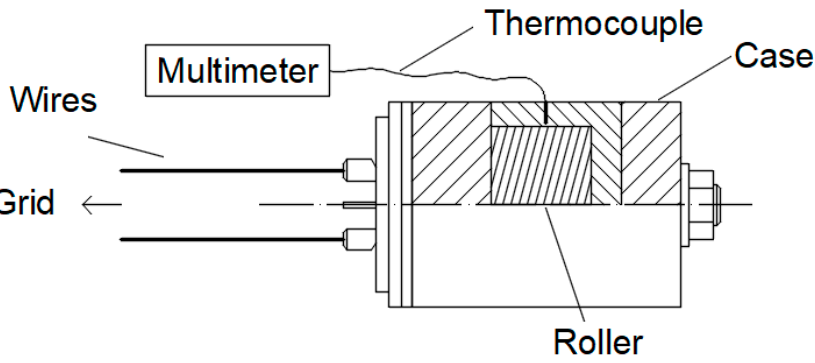
Figure 4. Placing the thermocouple in the capacitor case. The capacitor was connected to the grid under nominal conditions (230 V, 1.6 A). A photo showing the location of the thermocouple and the marker is shown in Figure 5.